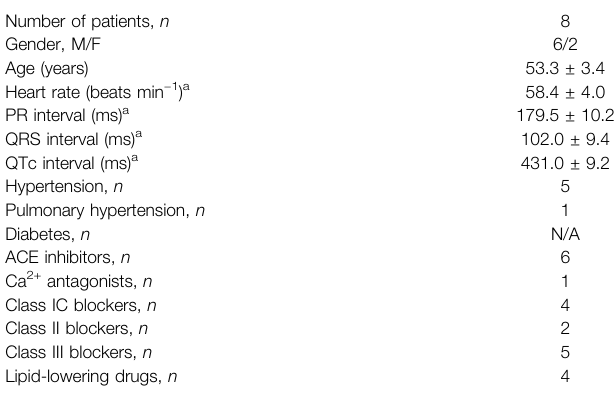
TABLE 1 | Patient characteristics. Number of patients,